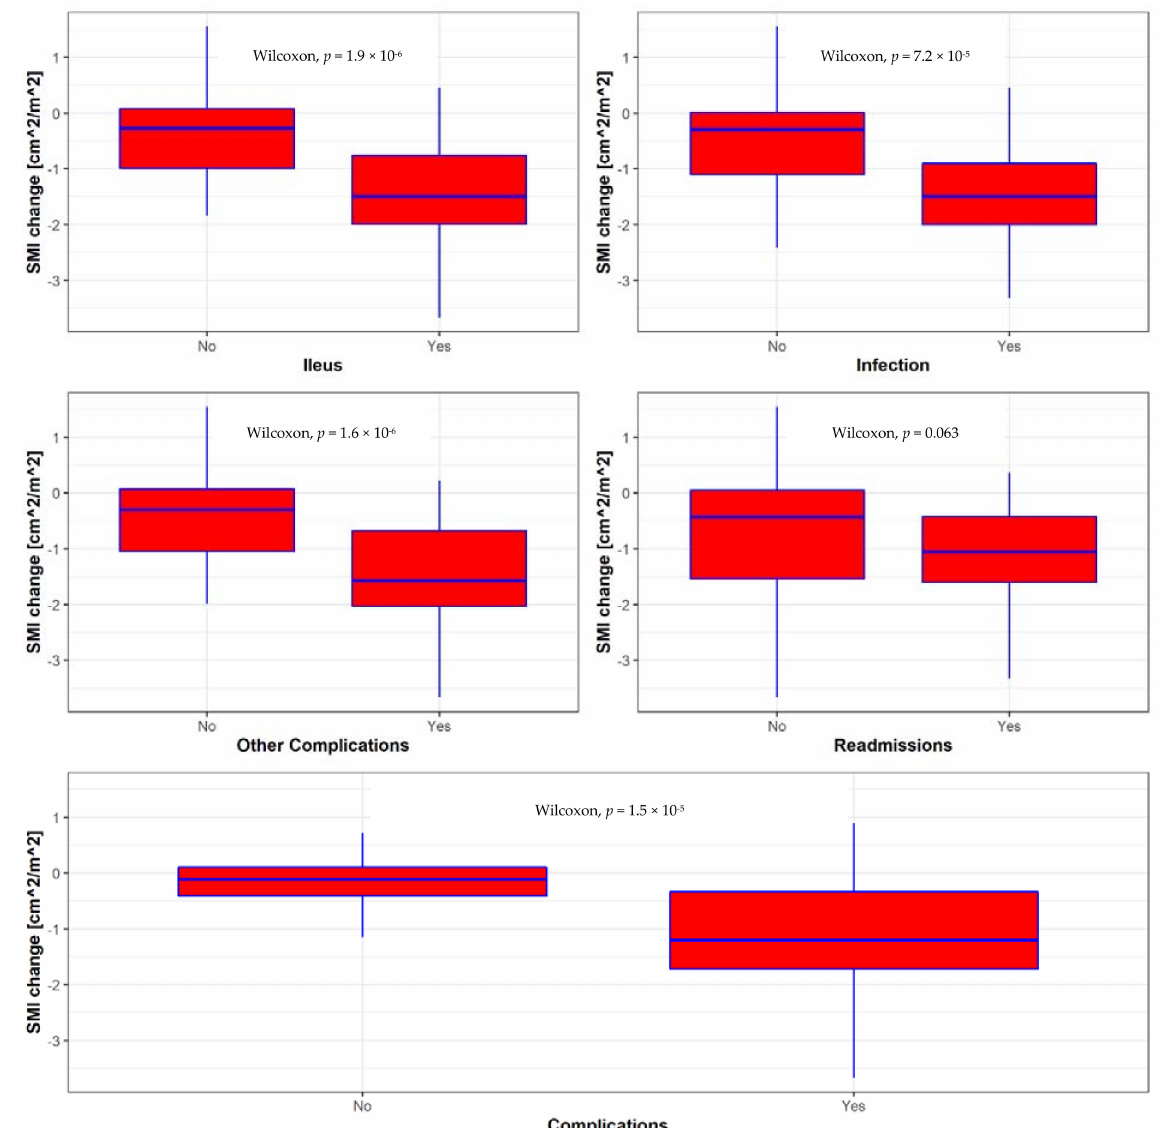
Figure 2. SMI change during NAC across the complication groups. SMI change was significantly lower in patients with